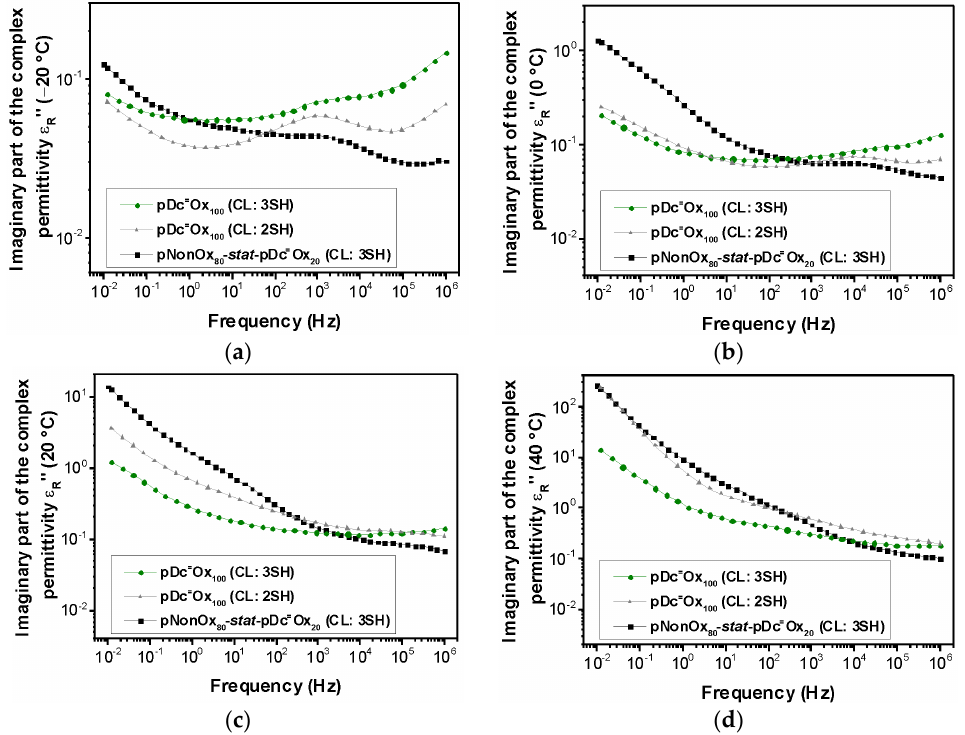
Figure 2. Frequency-dependent imaginary part of the complex permittivity of pNonOx 80 - stat -pDc = Ox 20 (CL: 3SH), pDc = Ox 100 (CL:2SH), and pDc = Ox 100 (CL:3SH) at − 20 °C ( a ), 0 °C ( b ), 20 °C ( c ) and 40 °C ( d ).